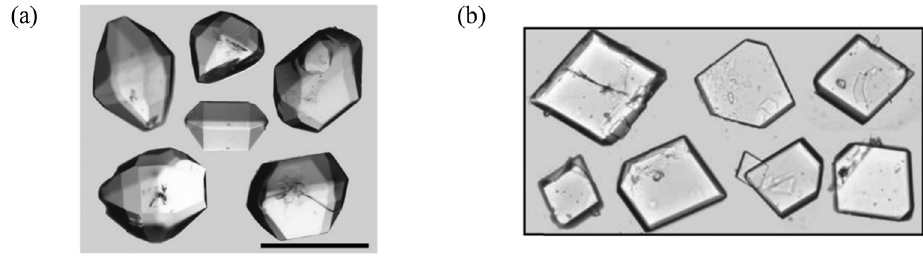
Figure 1: Prismatic habits of cocrystals: ( a ) CL - 20/TNT with a molar ratio of 1:1 [ 32 ] ; ( b ) CL - 20/HMX with a molar ratio of 2:1 [ 33 ] .